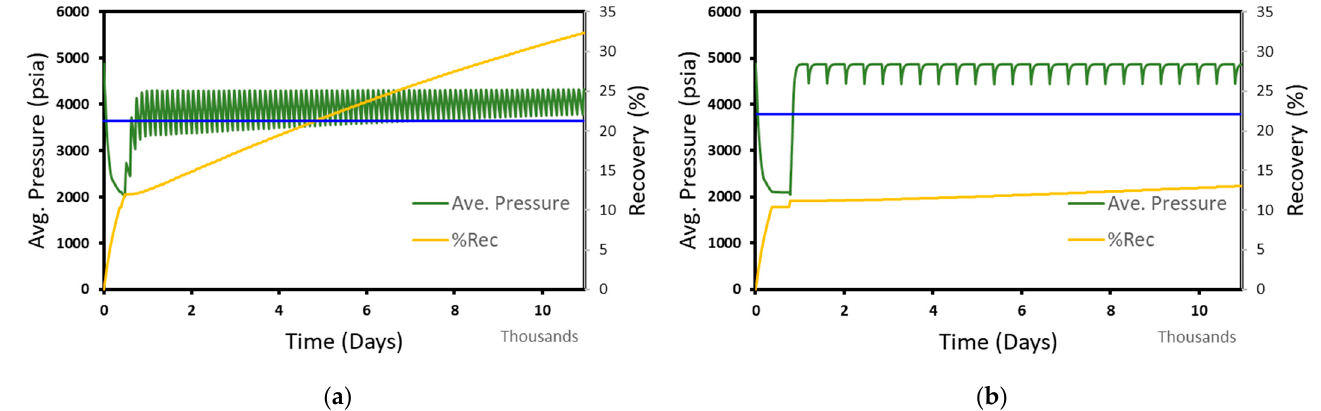
Figure 8. Average pressure and recovery percentage over time for ( a ) optimized HnP scenario; ( b ) suboptimal case.